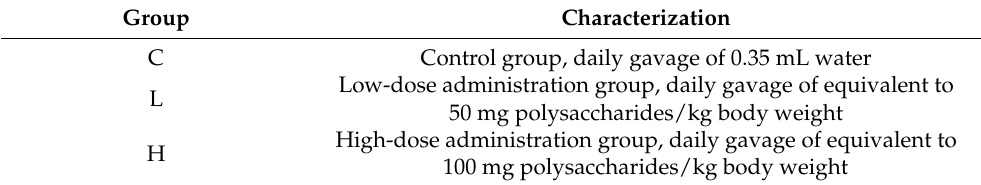
Table 1. Experimental groups. Group